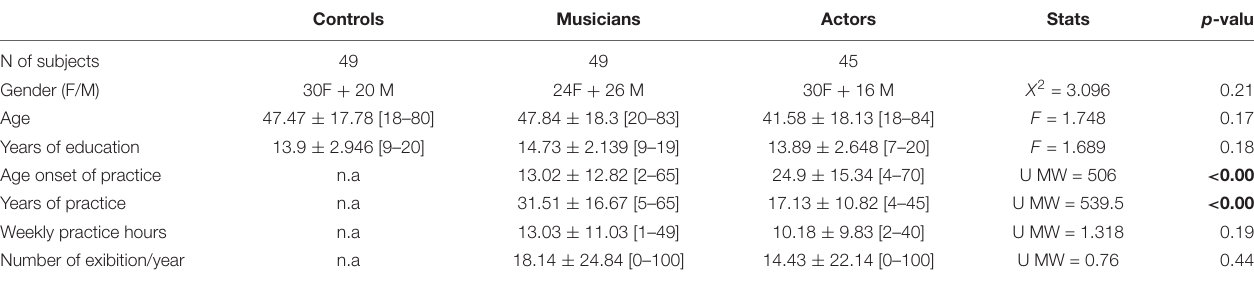
TABLE 1 | Demographic data of participants and practice background information for Musicians and Actors.